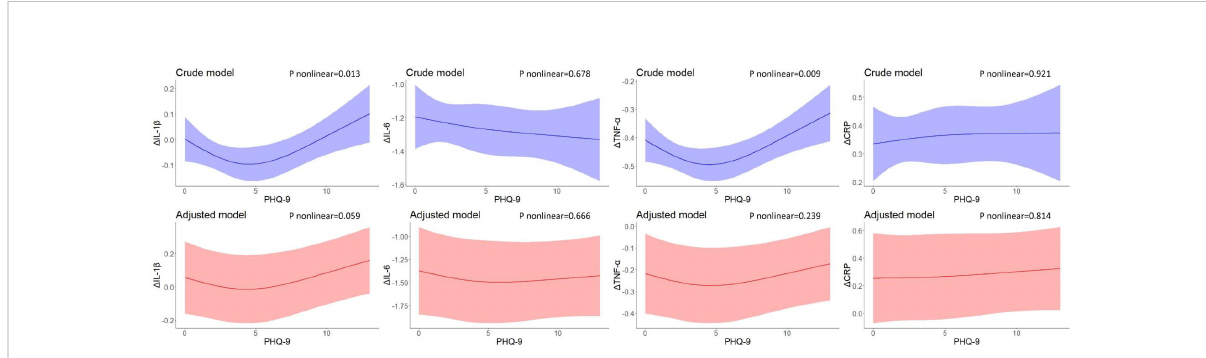
FIGURE 3 Restricted cubic spline models of the associations between PHQ-9 scores at baseline and changes in in fl ammatory biomarkers (n=248). IL-1 b , interleukin-1 b ; IL-6, interleukin-6; TNF- a , tumor necrosis factor- a ; CRP, C reactive protein. a The blue plot represented the crude model which was not adjusted by any variables, and the red plot represented the adjusted model which was adjusted by residential area, self-reported family economy, self-rated health condition, father ’ s education level, mother ’ s education level, cigarette use and alcohol use. b D represented changes between 2-year follow-up with baseline.